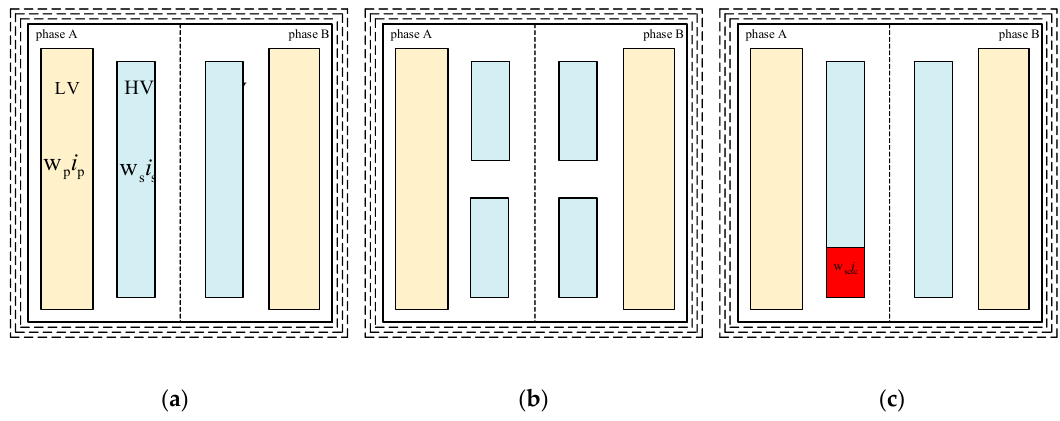
Figure 2. Examples of the location of windings in the air window of three phase transformers: ( a ) Symmetrical; ( b ) at voltage regulation; ( c ) at short circuit of a part of a winding.